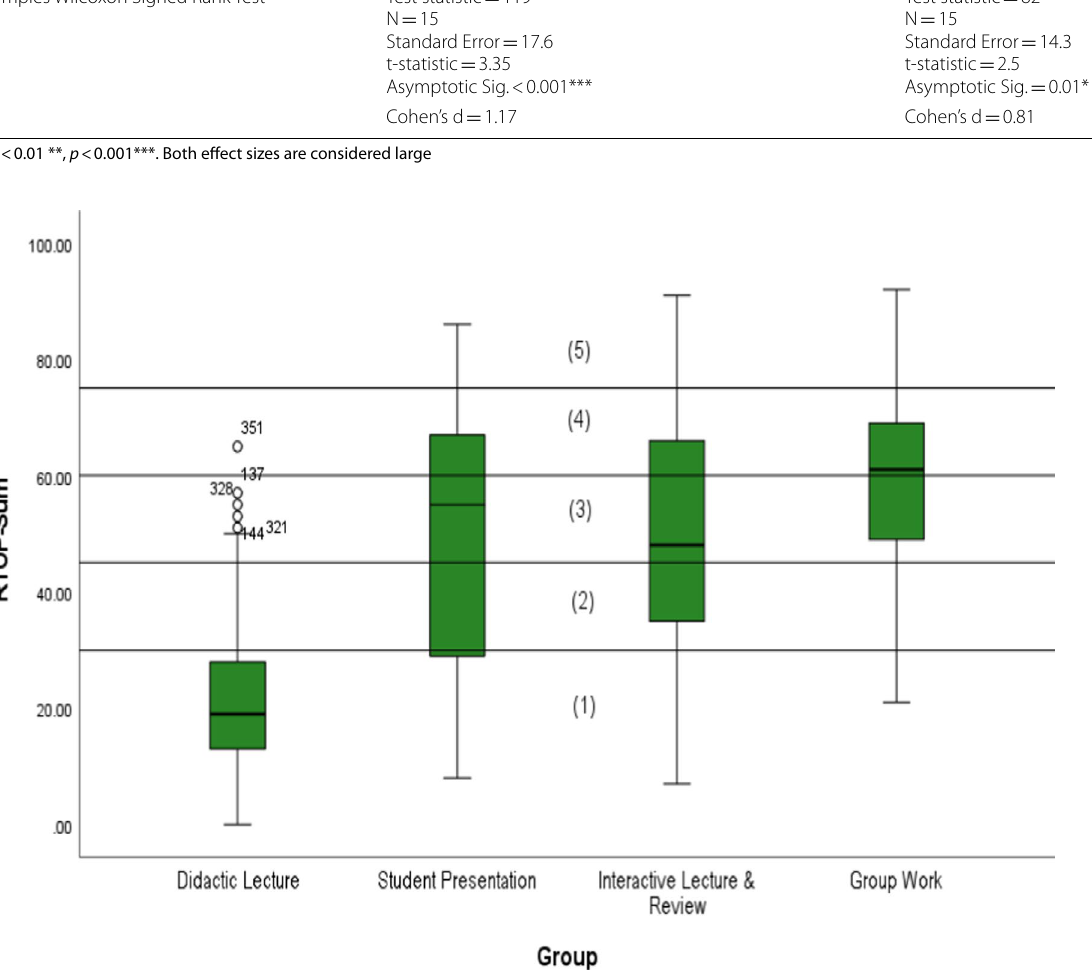
We plotted the RTOP scores for each LPA group identi- fied from TAMI-OP data. While the mean scores for each